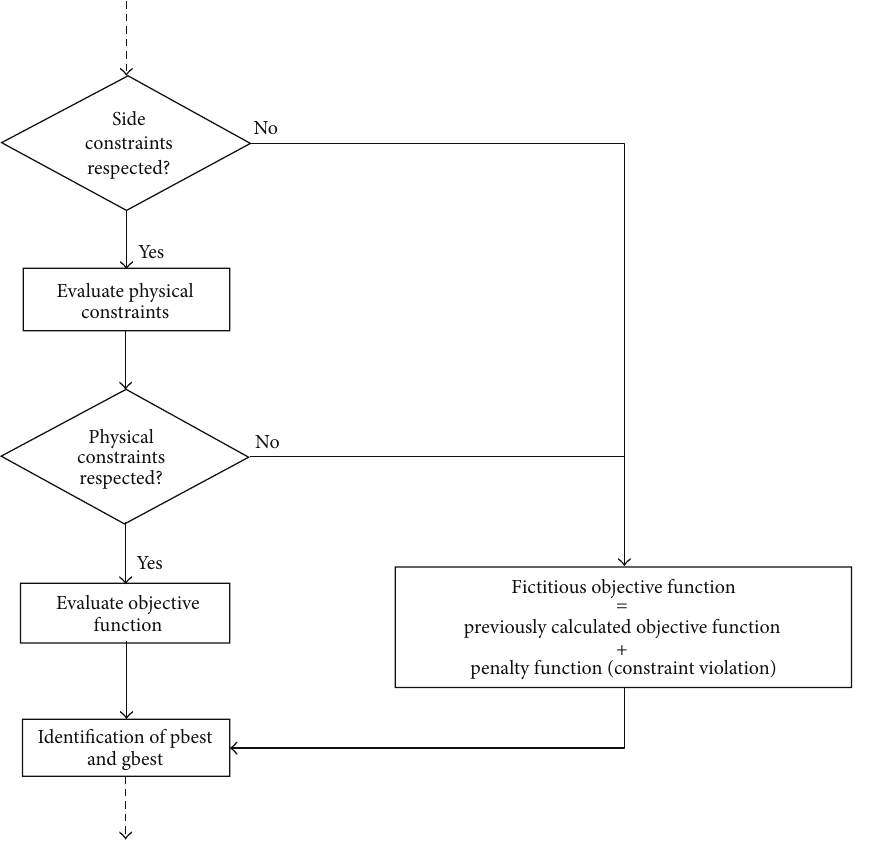
Figure 1: MCEPSO